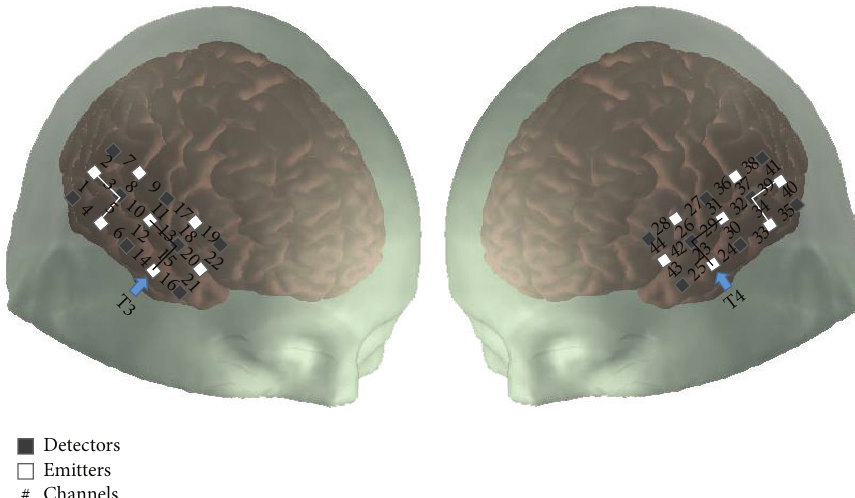
Figure 1: Configuration of channels (numbers) with identified detectors (dark gray squares) and emitters (white squares) over the right and left cortical hemispheres. There are 8 detectors and 7 sources resulting in 22 channels per hemisphere. The unit of concentration is micromolar ( 𝜇 M). Interconnected blocks with the solid black line represent the region of interest (ROI; primary auditory regions; channels 13, 15, 23, and 29). Interconnected blocks with white line represent the nonregion of interest (non-ROI; (channels 3, 5, 34, and 39)). T3 and T4 are the reference points of the International 10–20 System